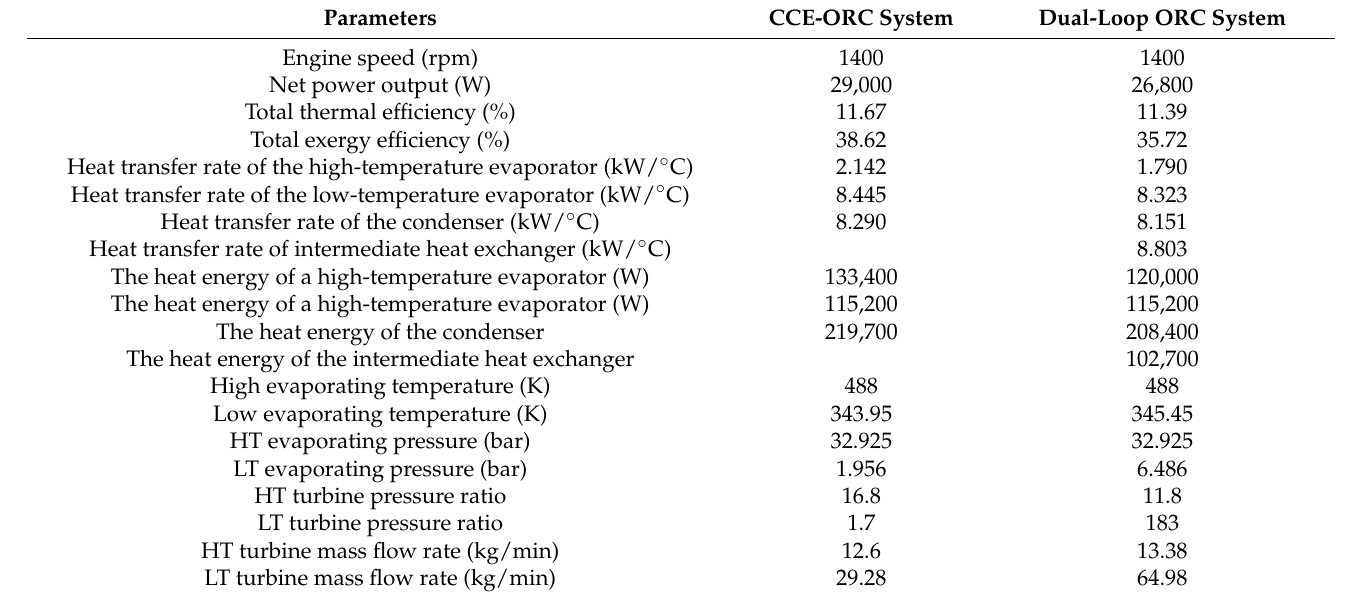
Table 4. Comparison between dual-loop ORC and CCE-ORC systems